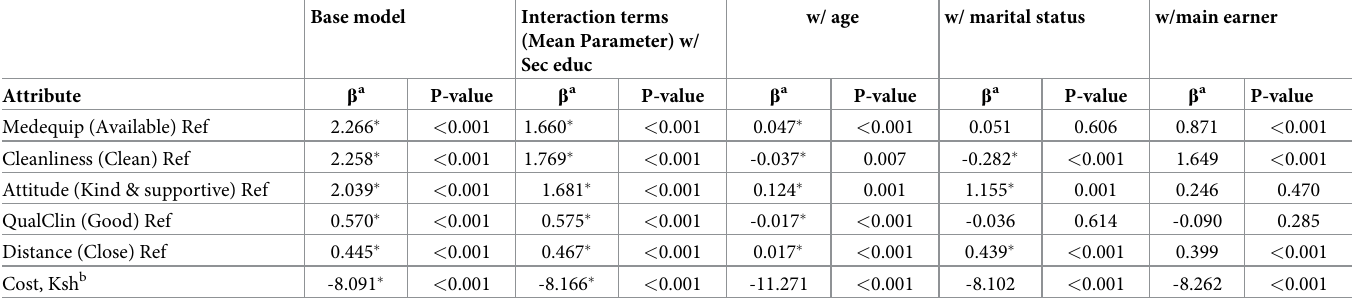
Table 5. Mixed logit model results with and without interactions for a discrete choice experiment addressing facility preferences for delivery among women, in a peri-urban setting in Kenya (N = 411).